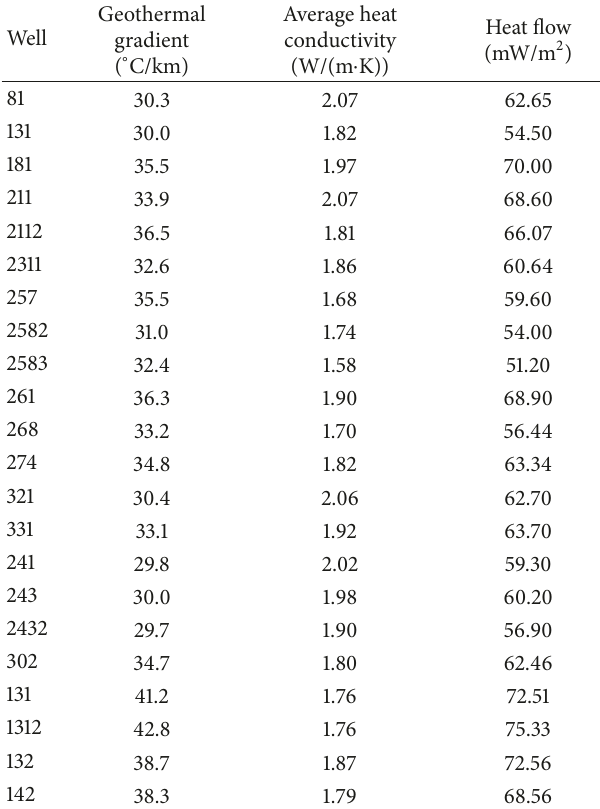
Table 7: Newly measured geothermal data of the Huizhou Sag